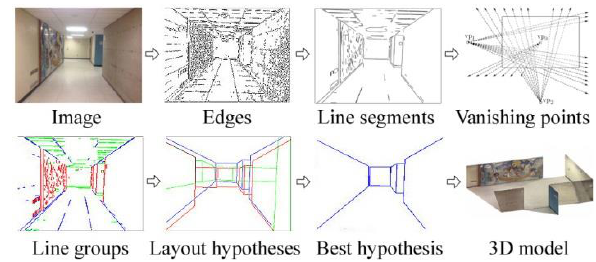
Figure 1. The proposed method detects edges and groups them into line segments. It estimates vanishing points, and creates layout hypotheses. It uses a linear scoring function to score hypotheses, and finally converts the best hypothesis into a 3D